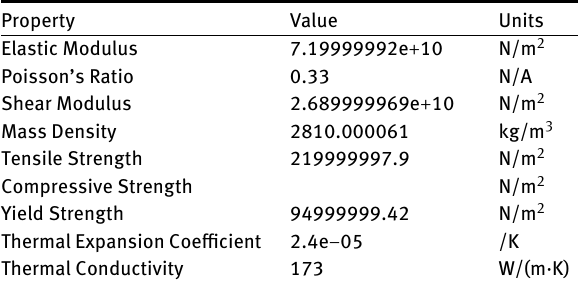
Figure 5: Front axle 2019. Table 2: Characteristic of duralumin alloy